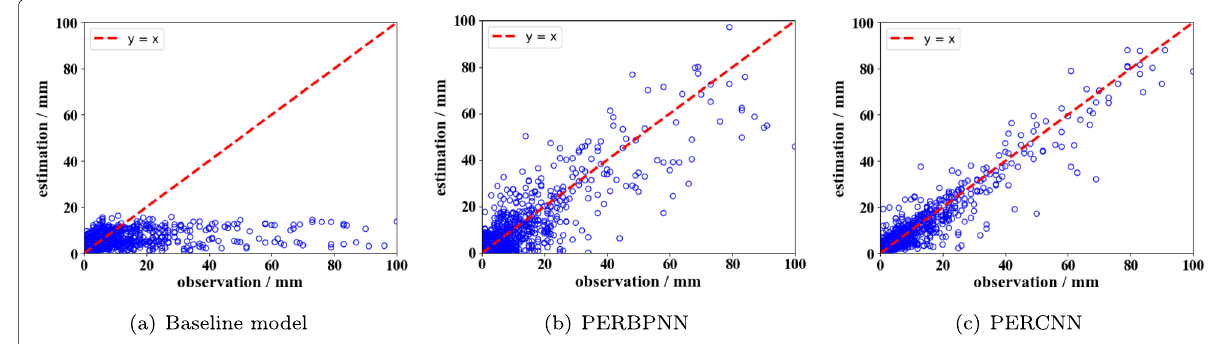
Fig. 9 The correlation between estimation and authentic value of different